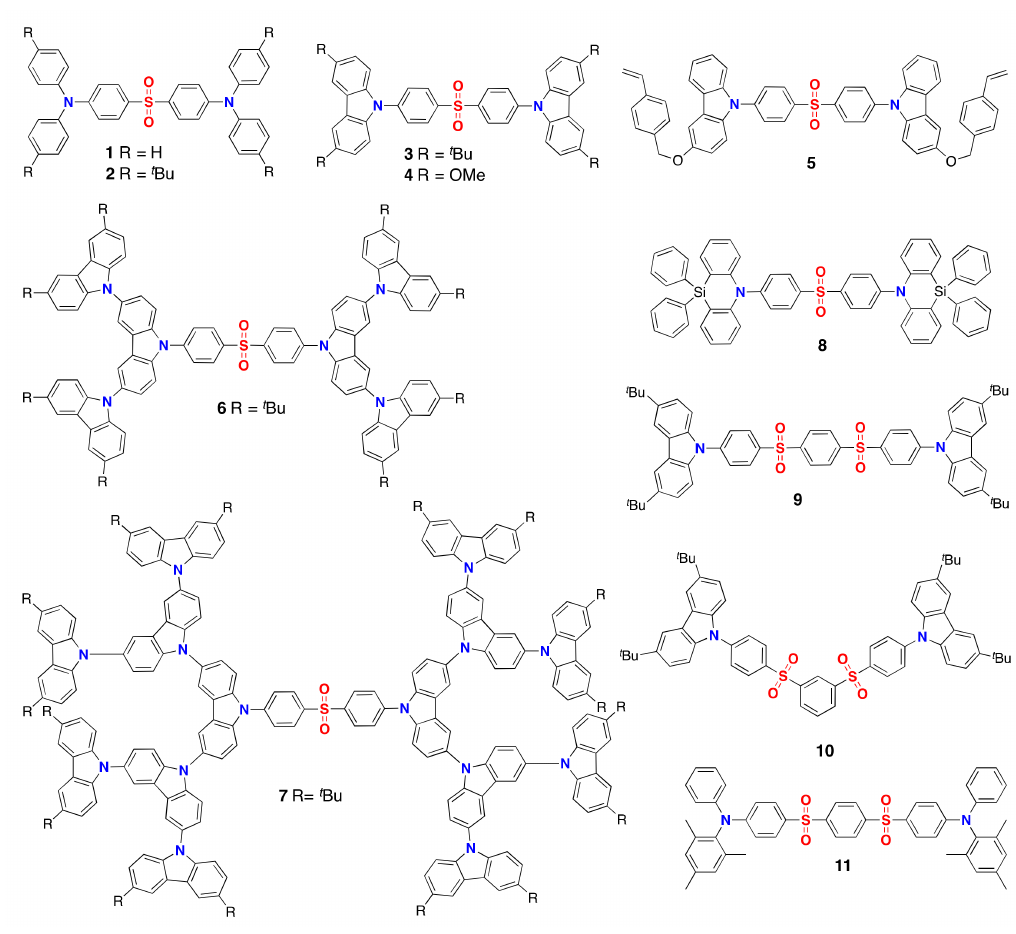
Figure 2. Diphenylsulfone-based ( 1 – 8 ) and bis (phenylsulfonyl)benzene-based ( 9 – 11 )